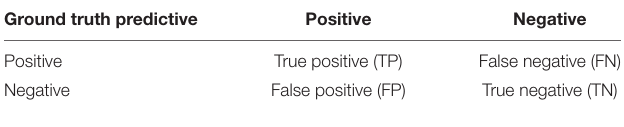
TABLE 3 | Obfuscation matrix for specified categories.